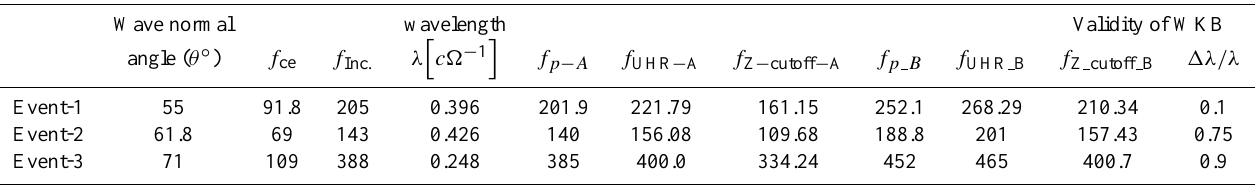
Fig. 6. Schematic illustration of (a) the definition of satellite coordinate and (b) the coordinate whose Z 0 -axis is along B 0 . Table 1. Parameters used in this study; wave normal angle, cyclotron frequency, incident wave frequency and plasma frequency, UHR- frequency and Z-cutoff in Region A and B (All of frequencies are in kHz).